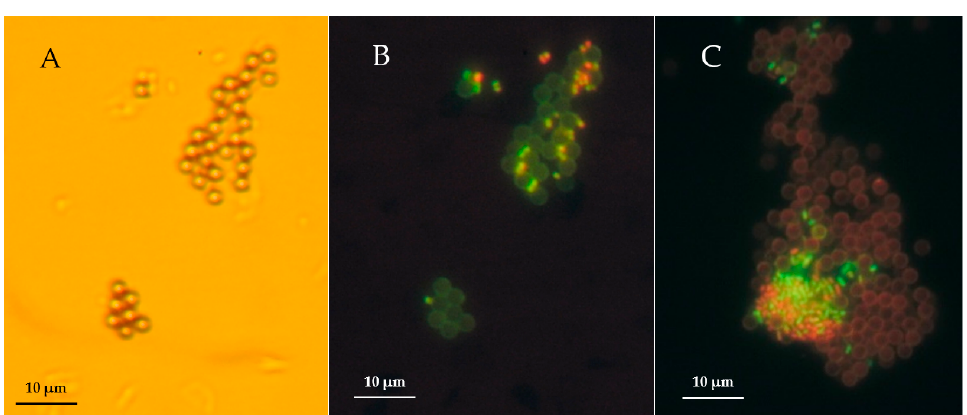
Figure 8. Comparison of transmission ( A ) and fluorescence microscopy ( B ) images of aggregates of MB, with Anti- E. coli O & K functionalization, mediated by captured E Coli bacteria. Example of a “false positive” sample ( C ) according to clinical laboratory data, i.e., bacteria mediated clustering for pathogens at concentrations below the positivity threshold set by the clinical laboratory.